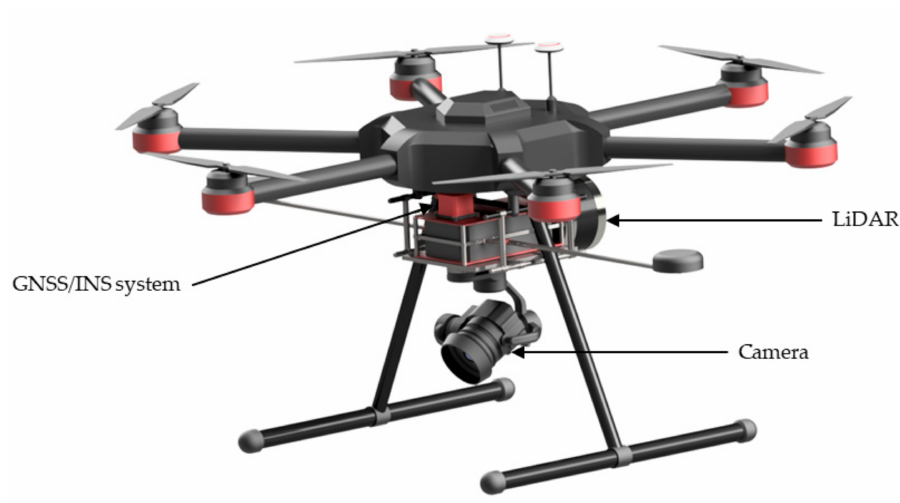
Figure 6. A concept of an optoelectronic module dedicated for an unmanned aerial vehicle (UAV), which will allow photogrammetric surveys in the coastal zone to be